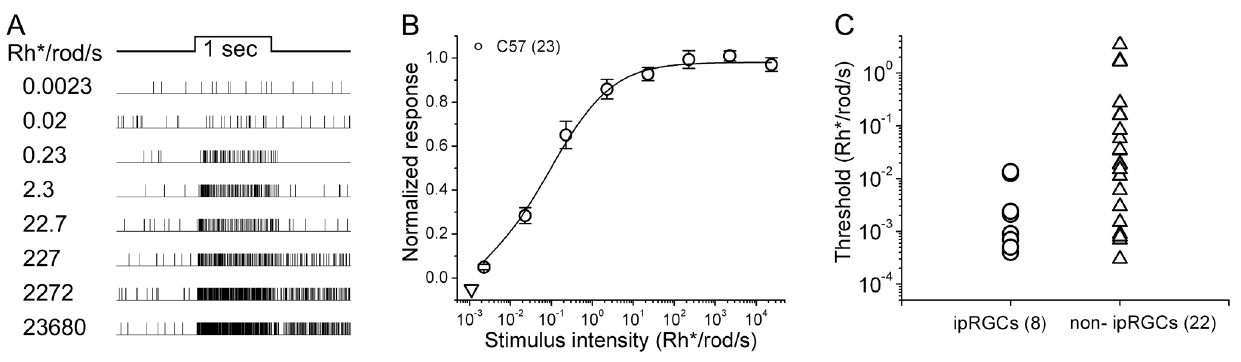
Figure 1. Pharmacological isolation of mouse ipRGCs . Representative raw voltage traces from a wildtype mouse retina (C57Bl6) recorded simultaneously from 15 electrodes of a multielectrode array. Most electrodes recorded spikes originating from more than one cell. Timing of full-field light stimulus is indicated by the step above the traces and by the time scales below the traces. Leftcolumn : Spike responses recorded in control Ames’ medium to a relatively dim scotopic flash (2.3 Rh * /rod/s; 500 nm; 1 second) that should excite rods but not cones or melanopsin[59]. Multiunit light responses are detectable on every channel, and exhibit various forms (ON, OFF or ON-OFF; transient or sustained). Rightcolumn : Light-evoked spike activity recorded on the same electrode in the presence of drugs blocking rod and cone signaling to ganglion cells. To permit activation of melanopsin, the stimulus was longer and . 10,000-fold brighter than that at left ( , 2 6 10 5 Rh * /rod/s sampled at 500 nm; 10 sec). This evoked responses on a minority of channels (arrows) and these exhibited the long onset latency and persistent post-stimulus discharge typical of